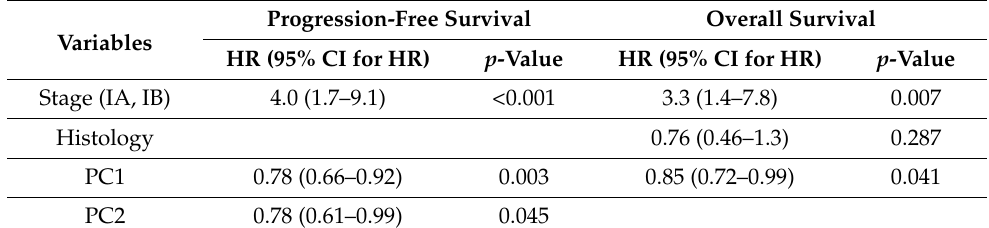
Table 4. Multivariate Cox regression analysis.